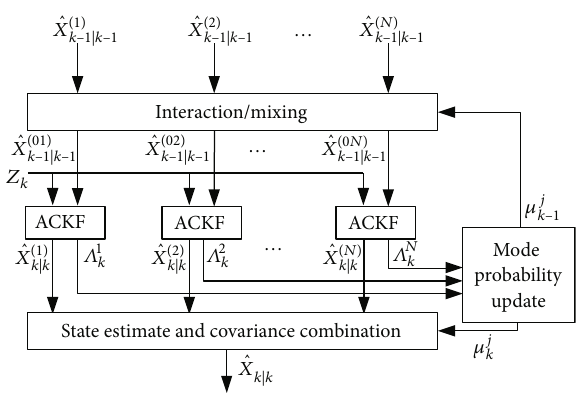
Figure 3: Schematic diagram of variable structure IMM trajectory tracking.